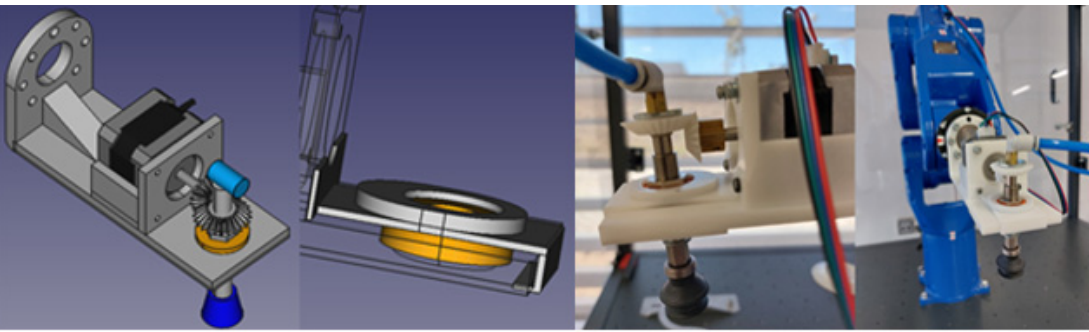
Figure 2. Model and prototype of the rotary suction cup. Source: (Own).